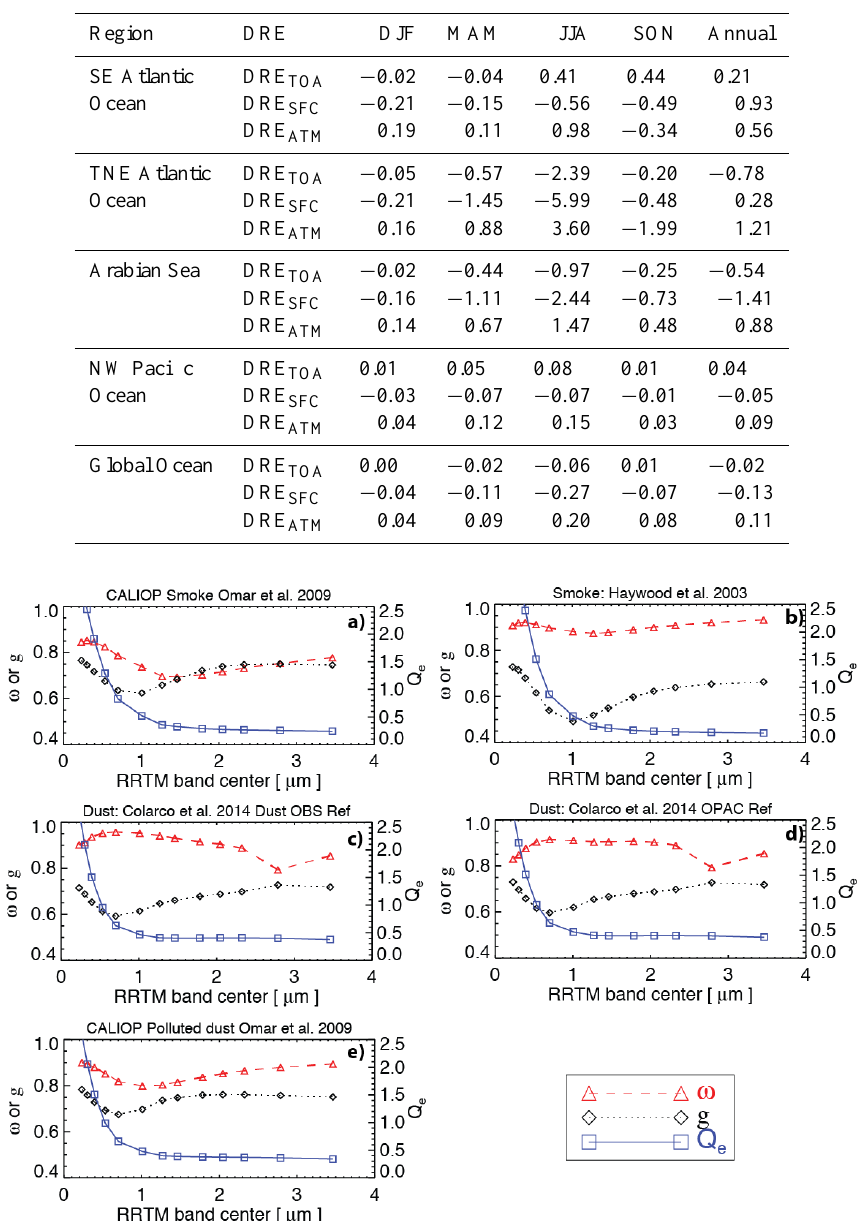
Figure 4. Single scattering properties, including extinction efficiency ( Q e ), single-scattering albedo ( ω ), and asymmetry factor ( g ) for (a) CALIOP smoke, (b) Haywood smoke, (c) OBS dust, (d) OPAC dust and (e) CALIOP polluted